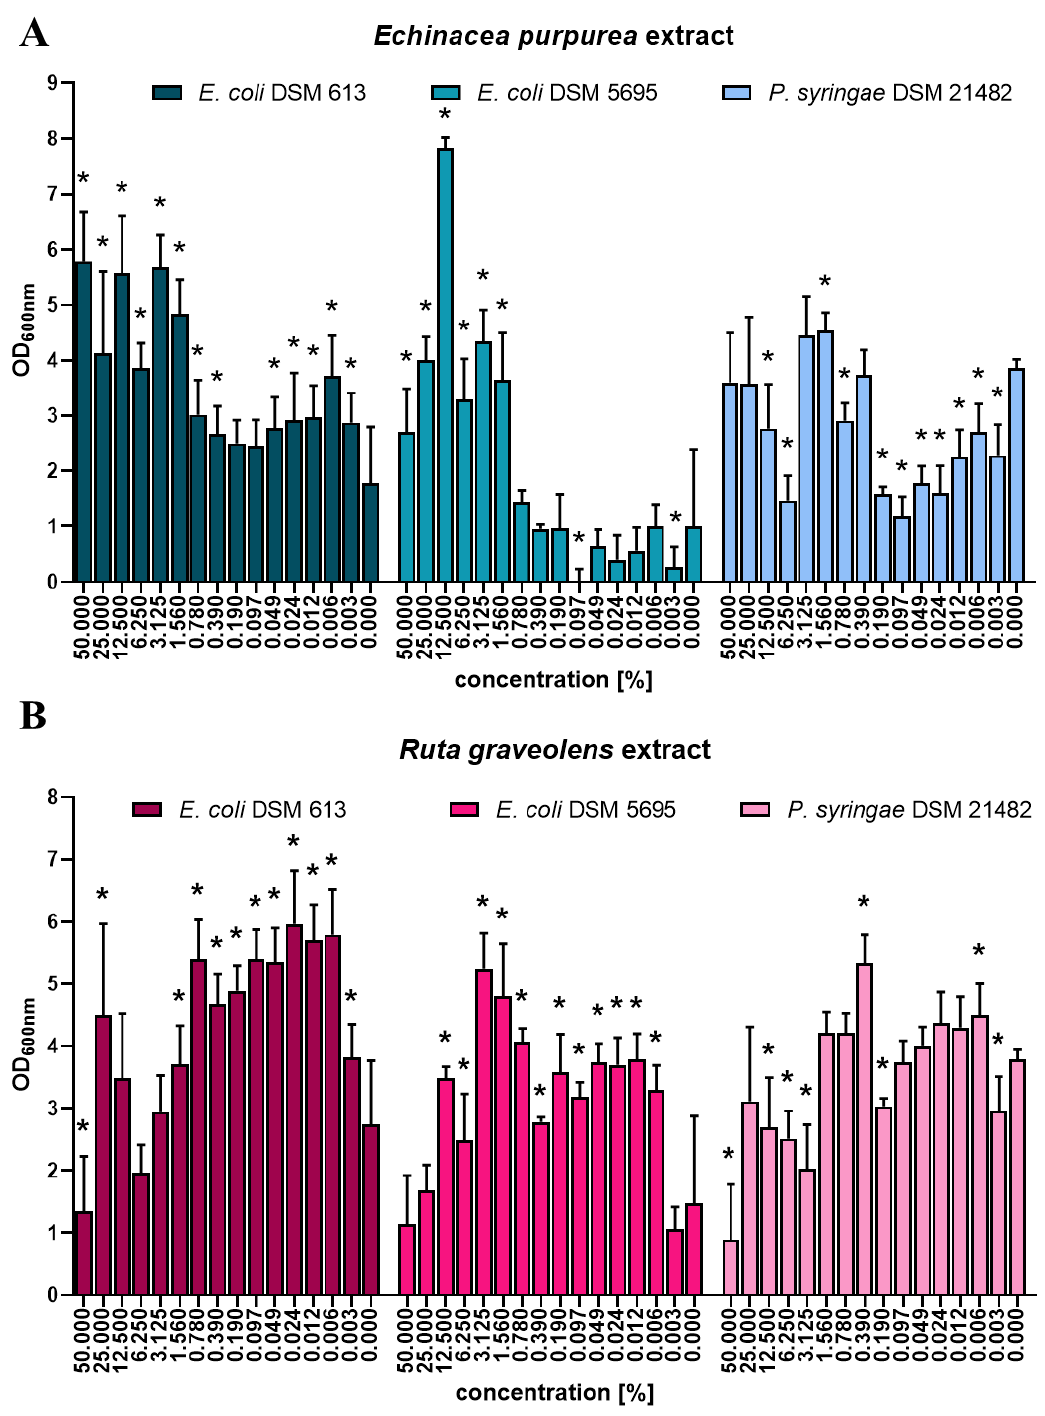
Figure 2. Bacterial biomass-altering activity of the tested plant extracts, measured after 24 h of incubation. Echinacea purpurea extract activity assessed by the microdilution method, ( A ) and Ruta graveolens extract activity assessed by the microdilution method ( B ). Error bars represent standard deviation (SD) between the samples. The means sharing the star asterisk are significantly different from the control (extract concentration 0%) at p ≤ 0.05.